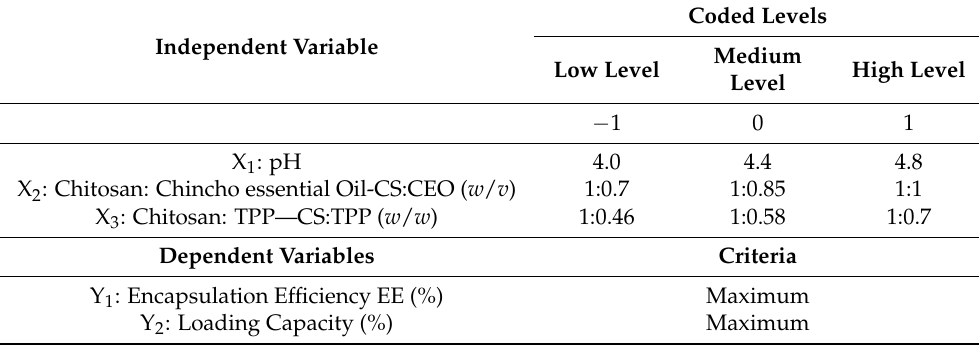
Table 6. Independent and dependent variables of the 3-level, 3-factor Box–Behnken design. Independent Variable